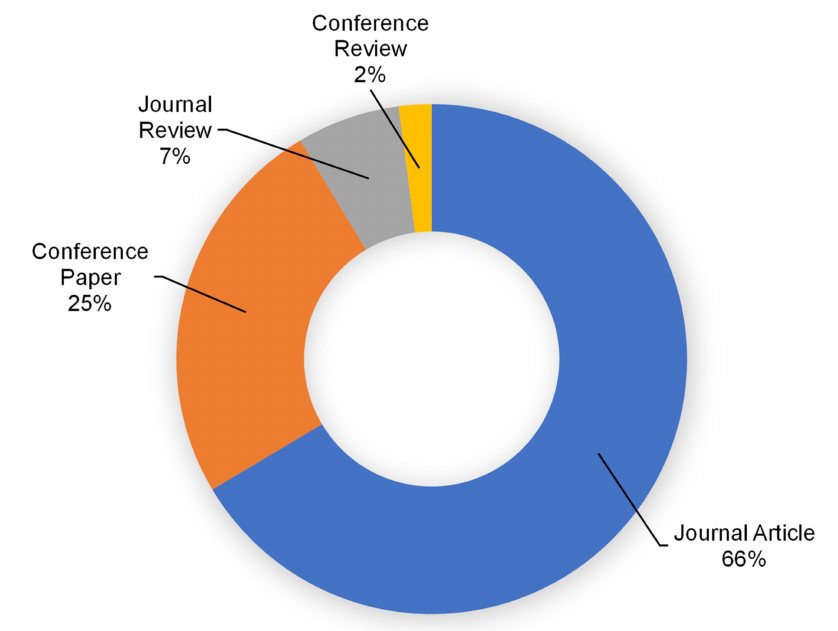
Figure 4. Various types of documents published in the related study